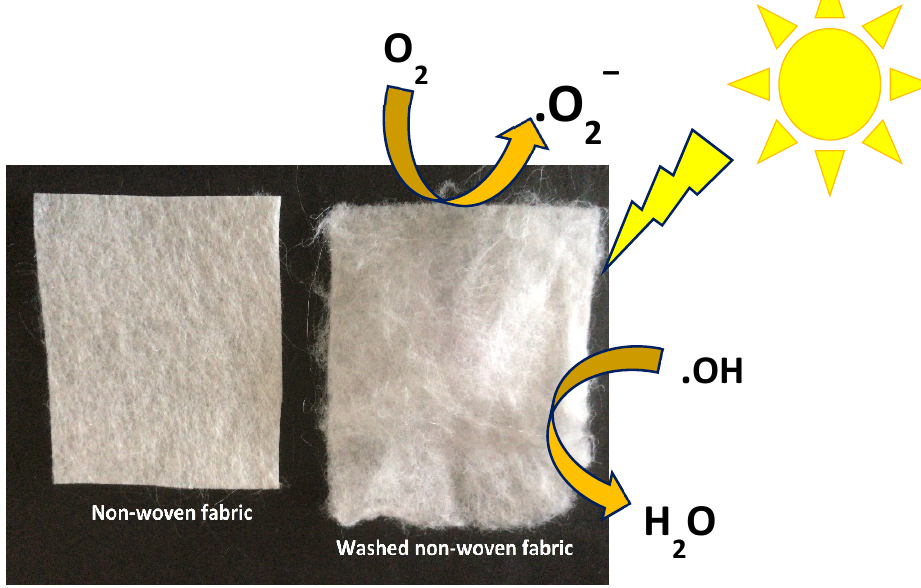
Figure 11. ( a ) Non-woven fabric with MB; and ( b ) non-woven fabric after one hour irradiation with UV lamp.